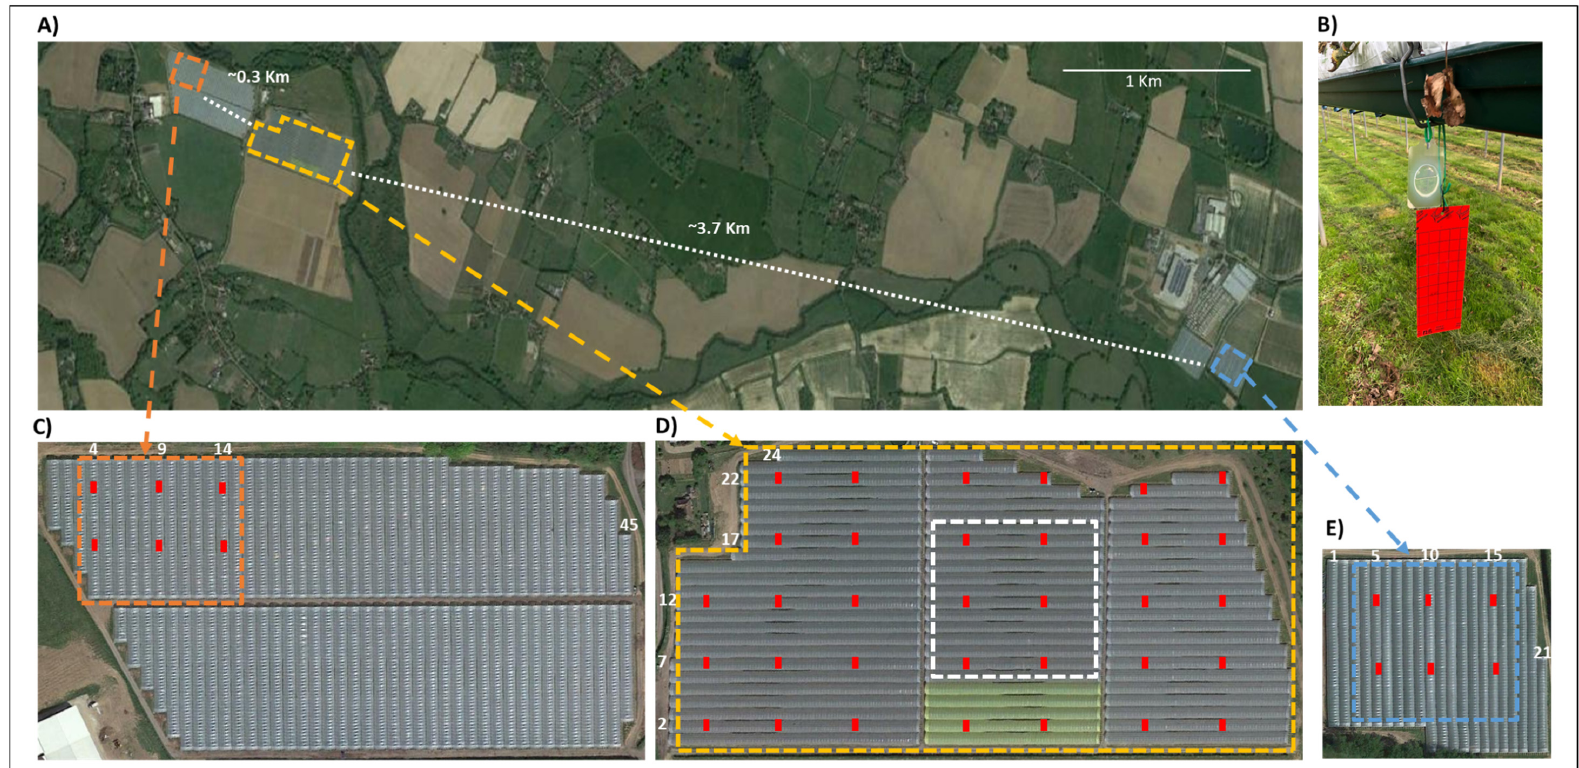
Figure 1. Relative position of experimental strawberry fields and monitoring traps within fields. ( A ) Satellite image of the region in Kent, UK, highlighting the position of the SIT-treated (dotted yellow lines) and untreated control sites (site 1—orange dotted lines; site 2—blue dotted lines). The distance between the sites is also shown. ( B ) Red sticky trap with a dry lure (Russell IPM) used to monitor the abundance of wild female SWD in the three sites. Their positioning is indicated by red rectangles on the images of individual sites. ( C ) Control site 1 and the position of six red sticky traps distributed among three tunnels. ( D ) SIT-treated site and the position of 33 traps distributed amongst 16 tunnels. ( E ) Control site 2 and the position of six red sticky traps distributed among three tunnels. Traps were distanced equally in the 3 sites, ~50 m within rows of polytunnels and 5 polytunnels apart (~40 m) from each other. The white rectangle in ( D ) represents a 1.4 ha “core area”, which was reproduced in each of the control sites. Photos were extracted from Google Earth.